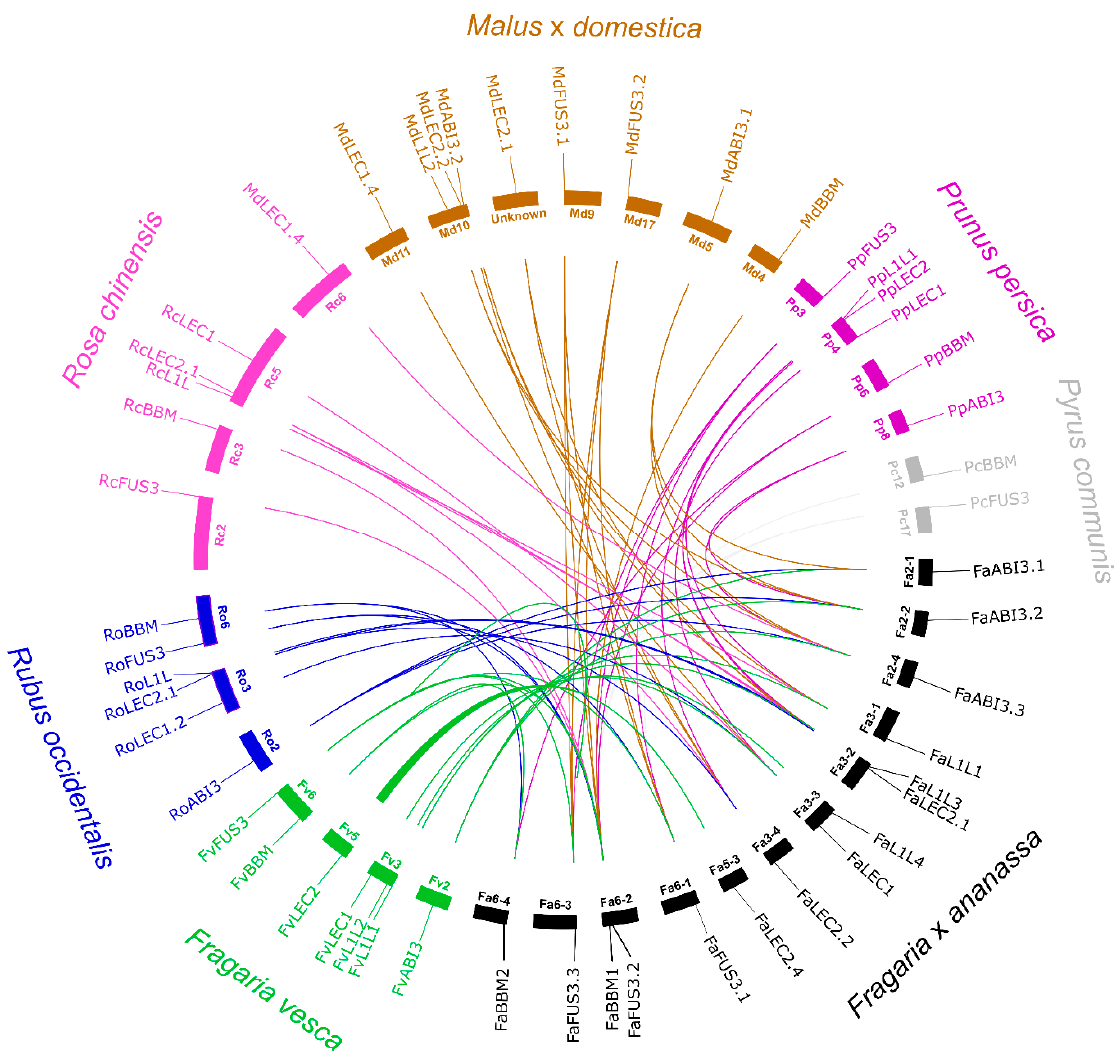
Figure 4. Chromosomal location and comparison of syntenic relationships between LEC1 , L1L , LEC2 , FUS3 , ABI3, and BBM genes for Fragaria × ananassa and other species of the Rosaceae family. FaLEC2.3 did not present synteny with any genes of Rosaceae species and it was excluded from the figure. Chromosomes for each species are indicated by color rectangles. Gene names for each species are indicated outside the circle. Colored lines indicate syntenic gene pairs between F. × ananassa and other species from the Rosaceae family. LEC1 : LEAFY COTYLEDON1 ; L1L : LEAFY COTYLEDON1-LIKE ; LEC2 : LEAFY COTYLEDON2 ; FUS3 : FUSCA3 ; ABI3 : ABSCISIC ACID INSENSITIVE3 ; BBM : BABYBOOM ; Fa: Fragaria × ananassa ; Fv: Fragaria vesca ; Ro: Rubus occidentalis ; Rc: Rosa chinensis ; Md: Malus × domestica ; Pp: Prunus persica ; Pc: Pyrus communis. Additional information about syntenic blocks is available in Table S4.